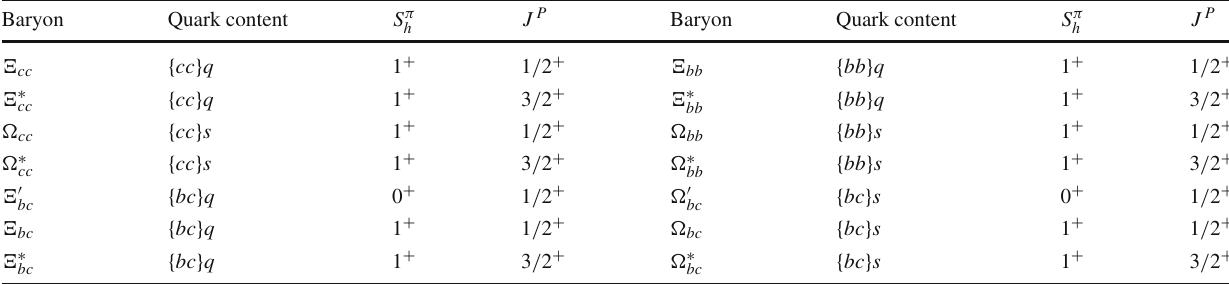
Table 1 Quantum numbers and quark content for the ground state of doubly heavy baryons. The S π The light quark q corresponds to u , d quark Baryon Quark content S π